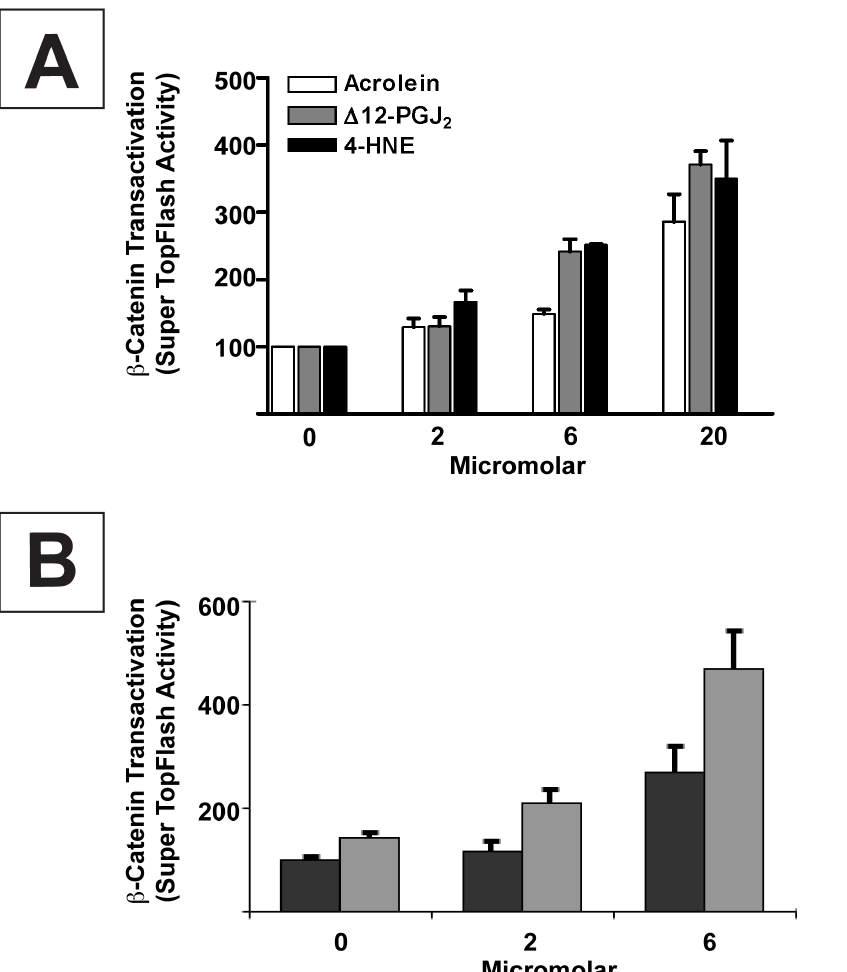
Figure 6. a , ß–unsaturated carbonyls enhance nuclear b -catenin signaling in STF3A cells:concentration-response relationships. ( A ) Nuclear b -catenin signaling (luciferase luminescence) in STF3A cells (2 6 10 4 cells/well) grown for 24 hrs in medium containing 0, 2, 6 and 20 m M each of acrolein ( % ), D 12 PGJ 2 ( & ) and 4-HNE ( & ). ( B ) Nuclear b -catenin signaling in STF3A cells (2 6 10 4 cells/well) grown for 24 hrs in medium containing 0, 2 or 6 m M of D 12 PGJ 2 alone ( & ) or D 12 PGJ 2 plus 100 m M BSO. GSH levels fell by 79% and 88% at 6 and 24 hrs after treating cells with BSO; 92– 95% of cells were still viable at 24 hrs. Bars represent the mean 6 s.e.m from n $ 3 separate experiments. doi:10.1371/journal.pone.0013545.g006 PLoS ONE |